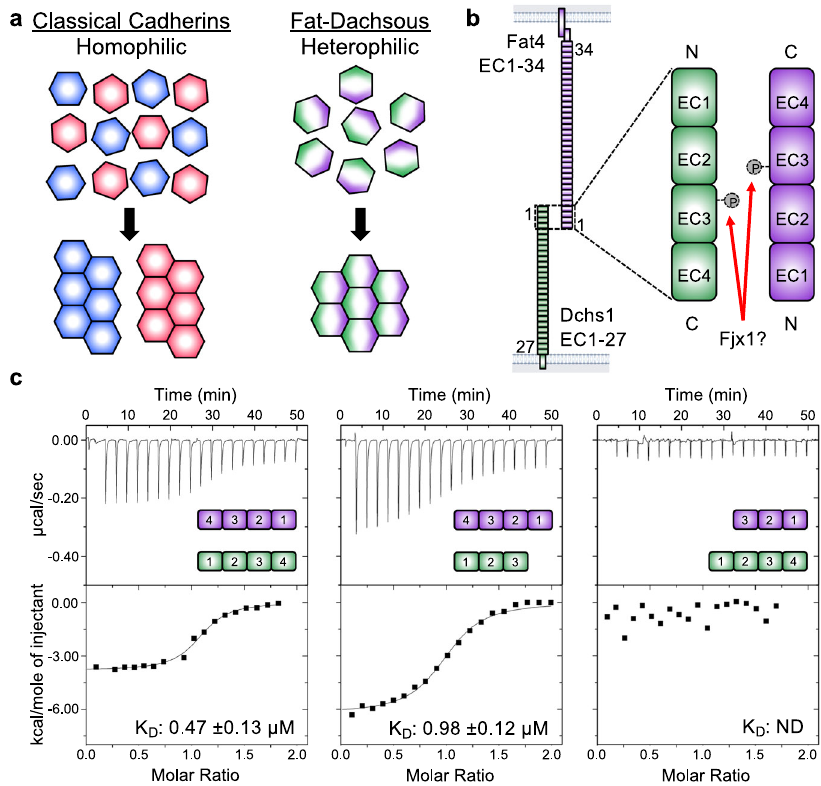
Fig. 1 | Binding af fi nity between Fat4 and Dchs1 truncations. a Simpli fi ed car- toon comparing tissue organization by classical cadherins and Fat – Dachsous cad- herins.Classicalcadherinsformhomophilicinteractionsbetweencellstosegregate tissues. Fat and Dachsous are expressed in the same cell and form heterophilic interactions to regulate planar cell polarity. b Schematic depicting the Fat4 and